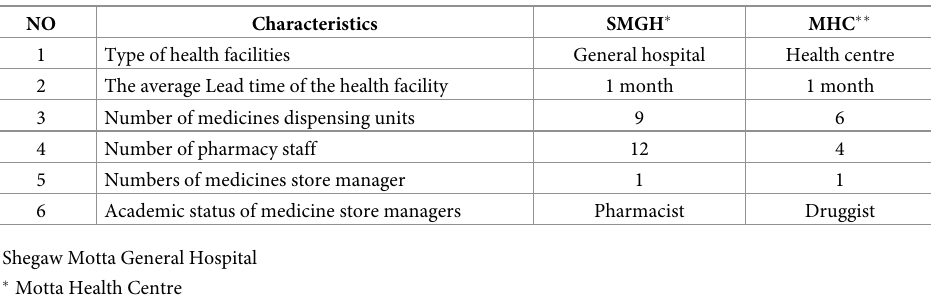
Table 1. General characteristics of health